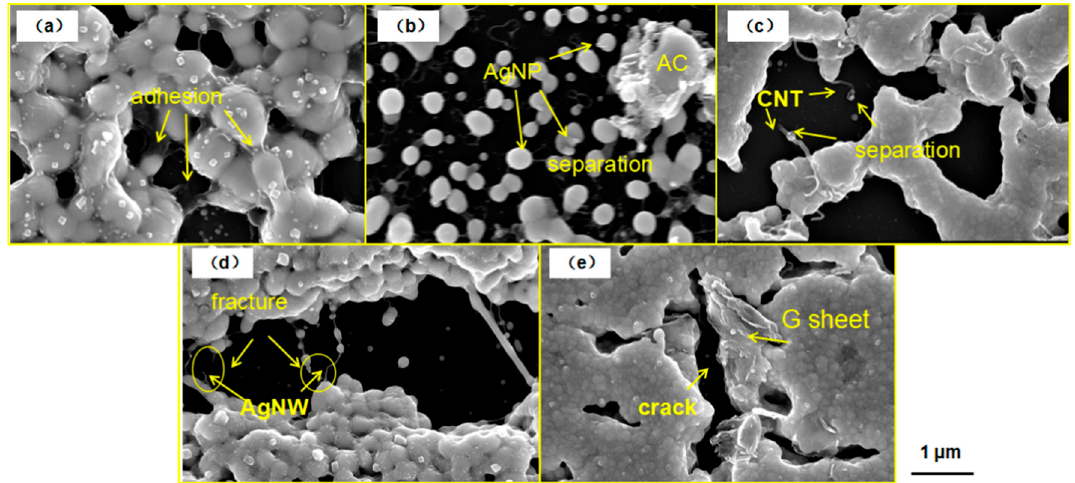
Figure 7. SEM images of composite electrodes with: ( a ) Ag NP; ( b ) Ag NP/AC; ( c ) Ag NP/CNT; ( d ) Ag NP/Ag NW; and ( e ) Ag NP/G fillers after bending test.